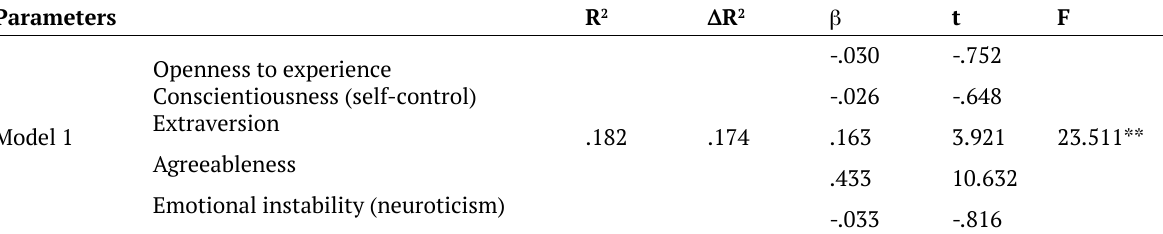
Table 7. Regression analysis results on the effect of personality scale sub-dimensions on exercise addiction